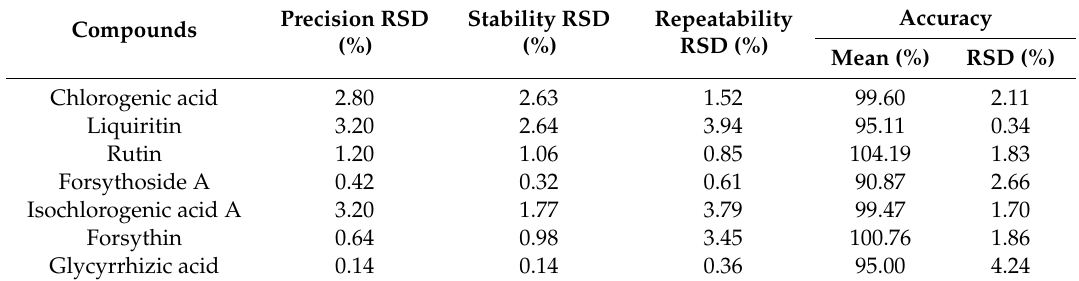
Table 2. The precision, stability, repeatability, and accuracy of the analytical method for seven compounds. Precision RSD Stability Compounds (%)